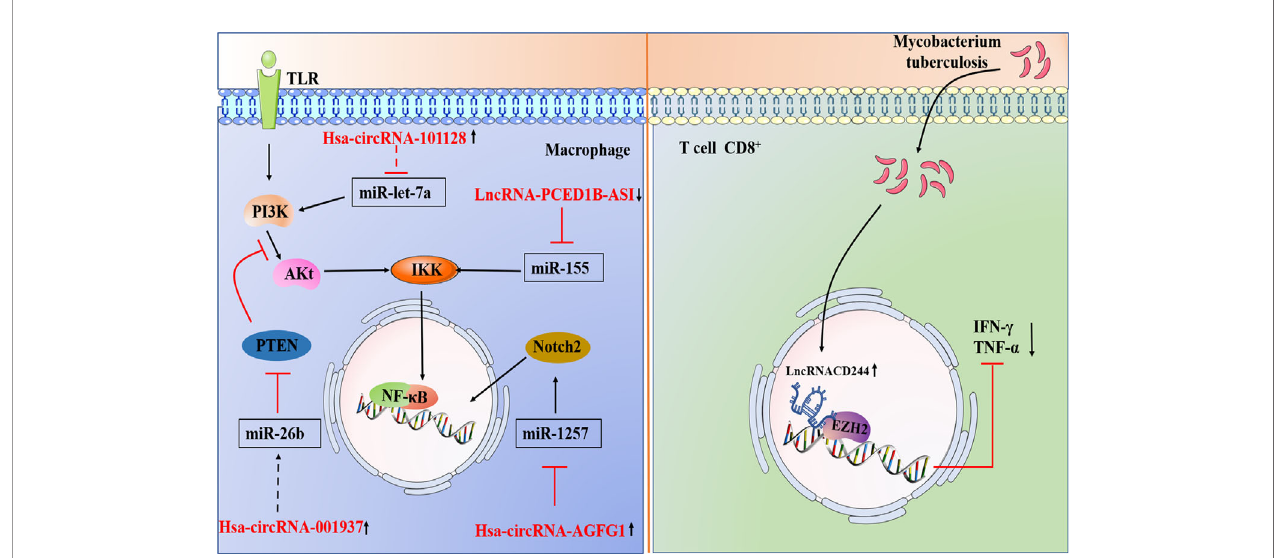
FIGURE 4 | 1.A brief summary of circRNA and LncRNA regulation of signaling pathways during M. tuberculosis infection. Hsa_circ_101128 may be involved in the pathogenesis of active TB by negatively regulating let-7a and may be involved in the MAPK and PI3K-AKT pathways. Hsa_circ_001937 potential miRNA target is miR-26b, which participate in the in fl ammatory response by modulating the NF- k B pathway by targeting PTEN. CircAGFG1 can enhance autophagy is achieved by targeting miRNA1257 to regulate Notch signal in the macrophages infected by M. tuberculosis . 2.Models involving lncRNAs that target the host immune system of M. tuberculosis . M. tuberculosis infection leads to upregulation of lncRNA-CD244 in CD8 + T cells, which interacts with chromatin modifying enzyme EZH2, and lncRNA-CD244 acts as an epigenetic regulator of IFN- g and TNF- a in CD8 + T cells and suppresses their expression to modulate the TB immune response of CD8 + T cells. Direct stimulatory modi fi cation; Direct inhibitory modi fi cation; Tentative stimulatory modi fi cation; Tentative inhibitory modi fi